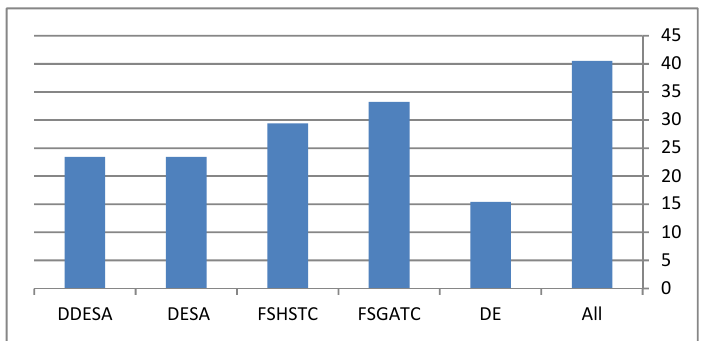
Figure 5. The execution time of the tested algorithms.